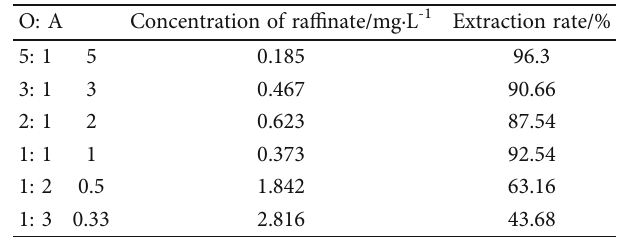
Figure 2: E ff ect of the O/A on extraction rate. Table 2: E ff ect of O/A on extraction